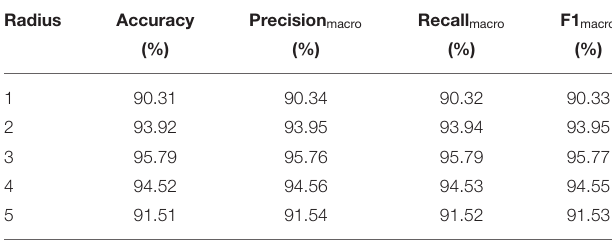
TABLE 4 | Experimental results with different